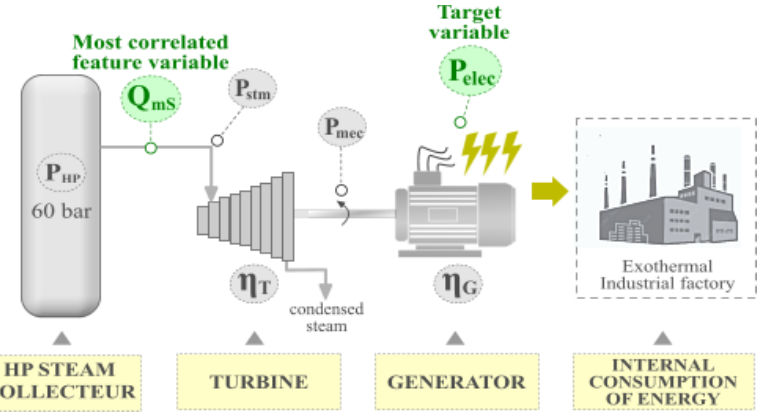
Figure 3. Simplified diagram showing the most correlated feature parameter of electrical power.